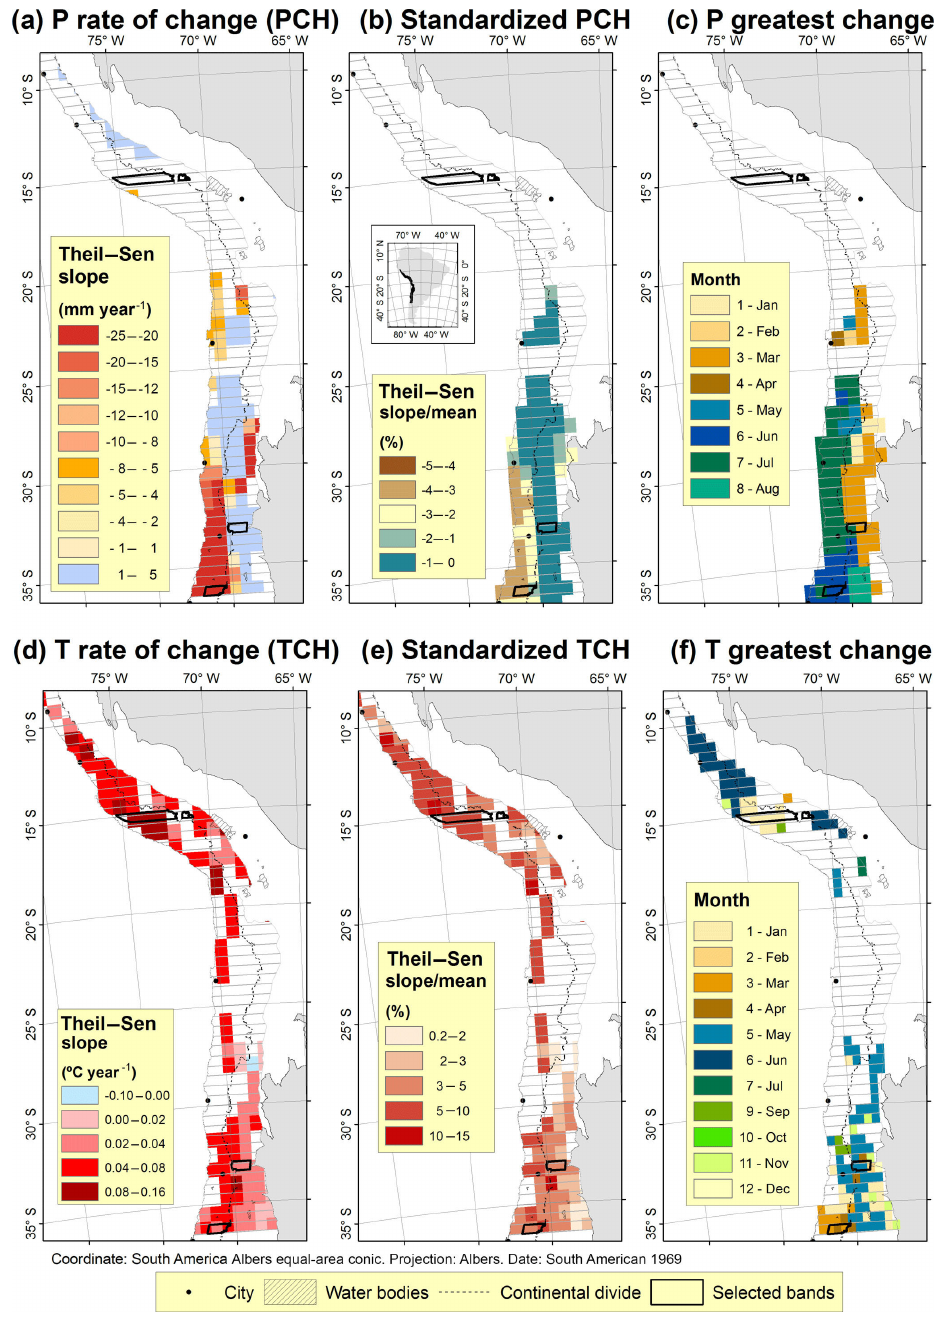
Figure 6. The Theil–Sen rate of change over the period 2000 to 2016, standardized Theil–Sen slope, and month of the greatest change (largest increase of temperature or largest decrease of precipitation) at an annual timescale for precipitation ( P ) (a, b, c) and air temperature ( T ) (d, e, f) ; only pixels with significant trends ( p ≤ 0.05) are colored. Black polygons highlight selected latitude bands used to describe in detail the evolution of temperature, precipitation, and snow from 1960 to 2016 (Fig.